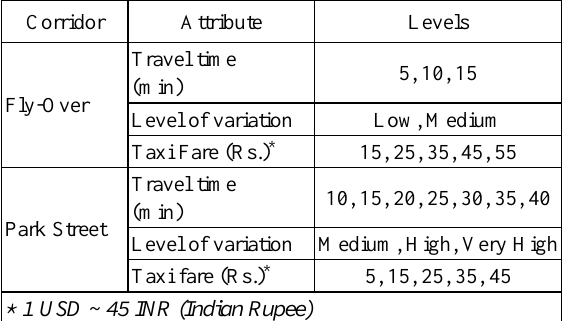
Table 1. Attributes and their levels for private car trip makers Corridor